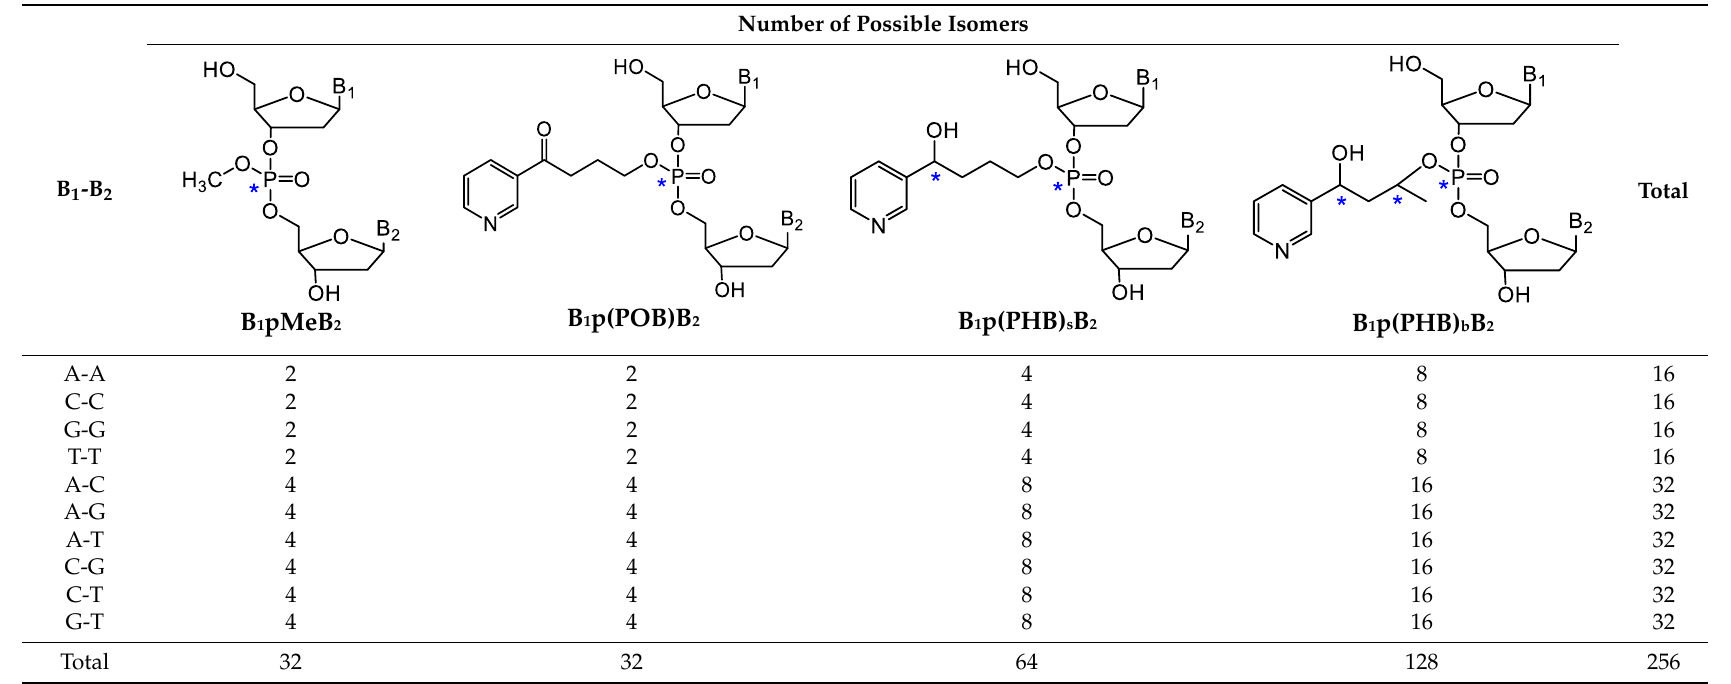
Table 2. Numbers of possible isomers of NNK-derived DNA phosphate adducts. Table 2 . Numbers of possible isomers of NNK-derived DNA phosphate adducts . Table 2 . Numbers of possible isomers of NNK-derived DNA phosphate adducts . Table 2 . Numbers of possible isomers of NNK-derived DNA phosphate adducts . Table 2 . Numbers of possible isomers of NNK-derived DNA phosphate adducts